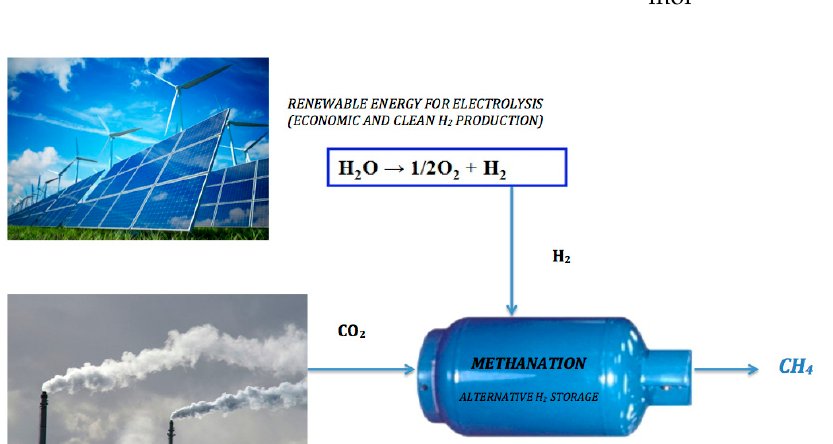
Figure 1. CO 2 methanation as an alternative to H 2 storage.